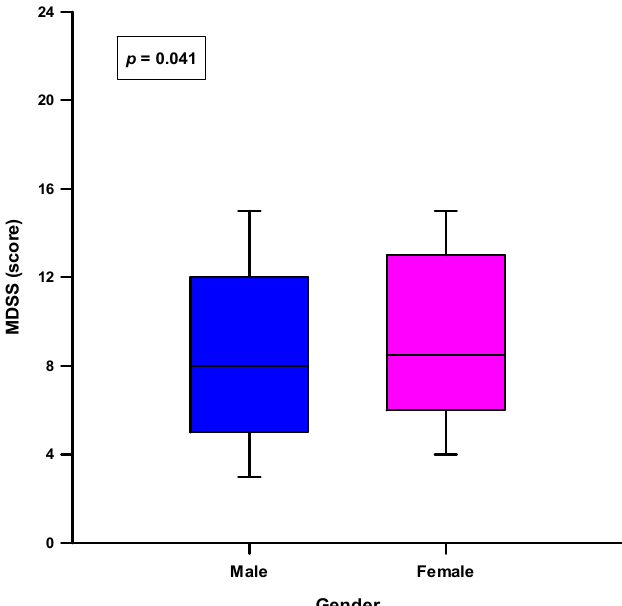
Figure 2. Correlation between the total MDSS score and the total MET min/week in the whole study sample ( n = 1220). * Spearman’s correlation coefficient.